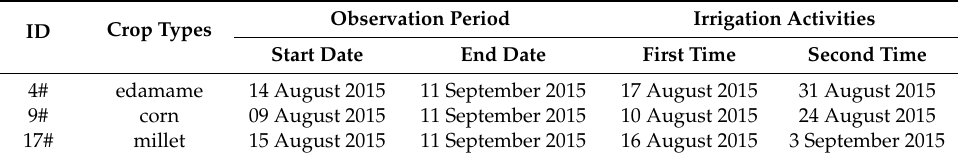
Table 2. Schedule of soil moisture observation and irrigation